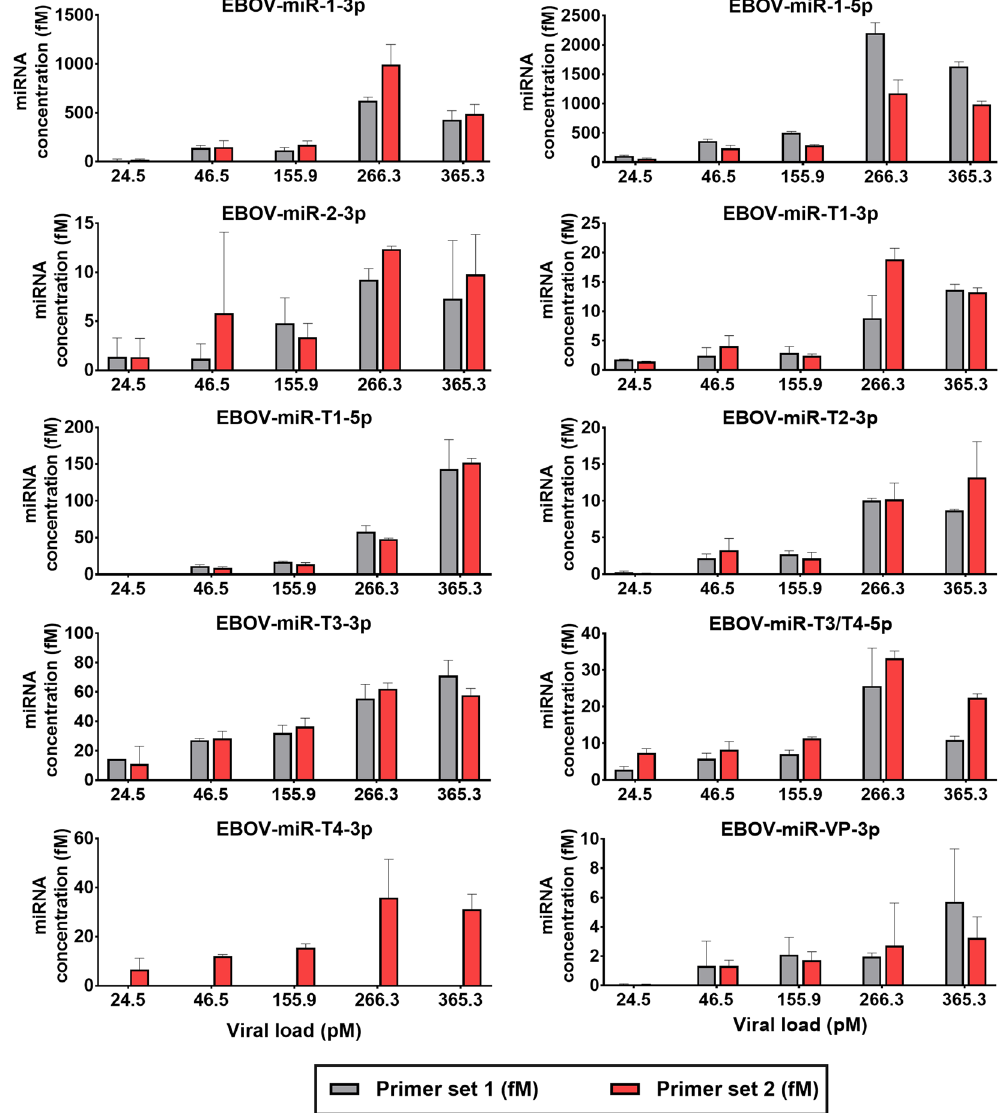
Figure 3. EBOV-encoded miRNAs were detectable in the plasma of EBOV/Kikwit-infected NHPs. Ten candidate miRNAs were detected by 19 LNA primer sets in rhesus macaque plasma from an EBOV/Kikwit infection cohort (NHP n = 3). Data are presented as the mean ± SD of biological replicates run in technical triplicate. miRNAs were assayed with custom LNA primer sets obtained from Exiqon, Inc. following manufacturer’s instructions (see Methods for details). Each miRNA target was amplified by two separate primer sets. Viral load was determined using an RT-qPCR assay which amplifies part of the viral glycoprotein